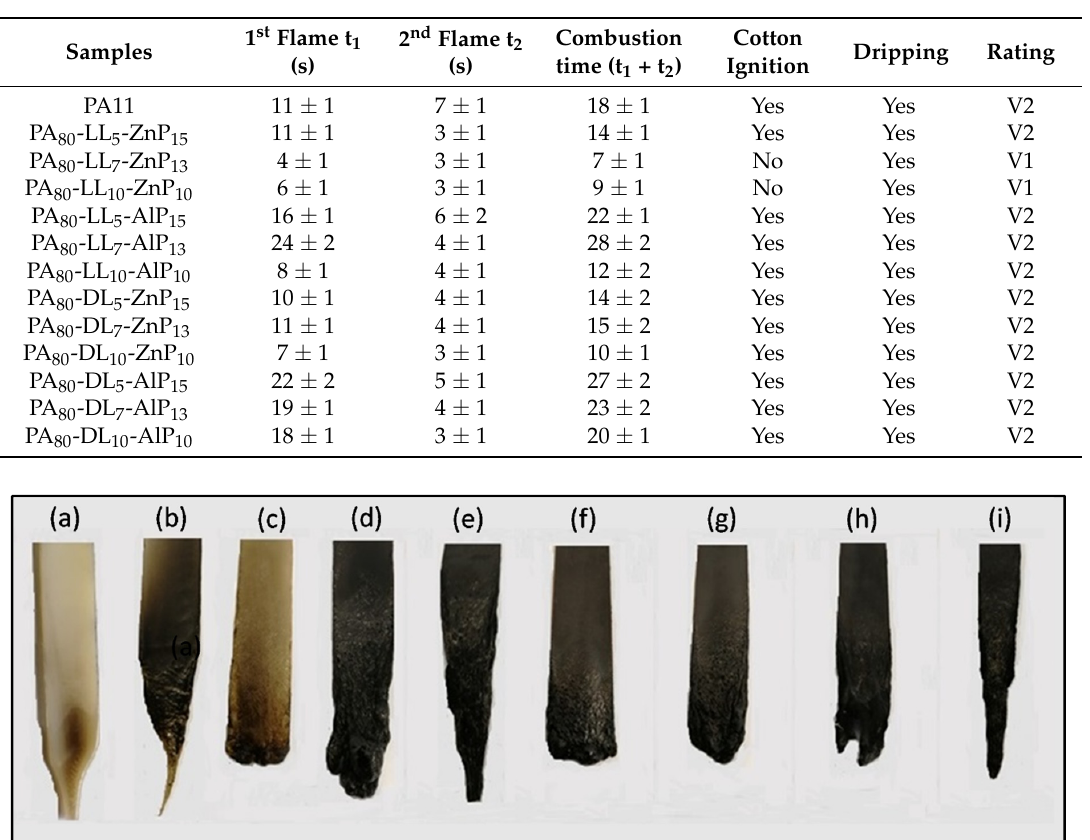
Figure 6. Pictures of PA11 blends specimen left after UL 94 vertical flame test. ( a ) PA11; ( b )PA 80 -ZnP 20 ; ( c ) PA 80 -AlP 20 ; ( d ) PA 80 -LL 20 ; ( e ) PA 80 -DL 20 ; ( f ) PA 80 -LL 10 -ZnP 10 ; ( g ) PA 80 -DL 10 -ZnP 10 ; ( h ) PA 80 -DL 10 -ZnP 10 ; ( i ) PA 80 -DL 10 -AlP 10 .